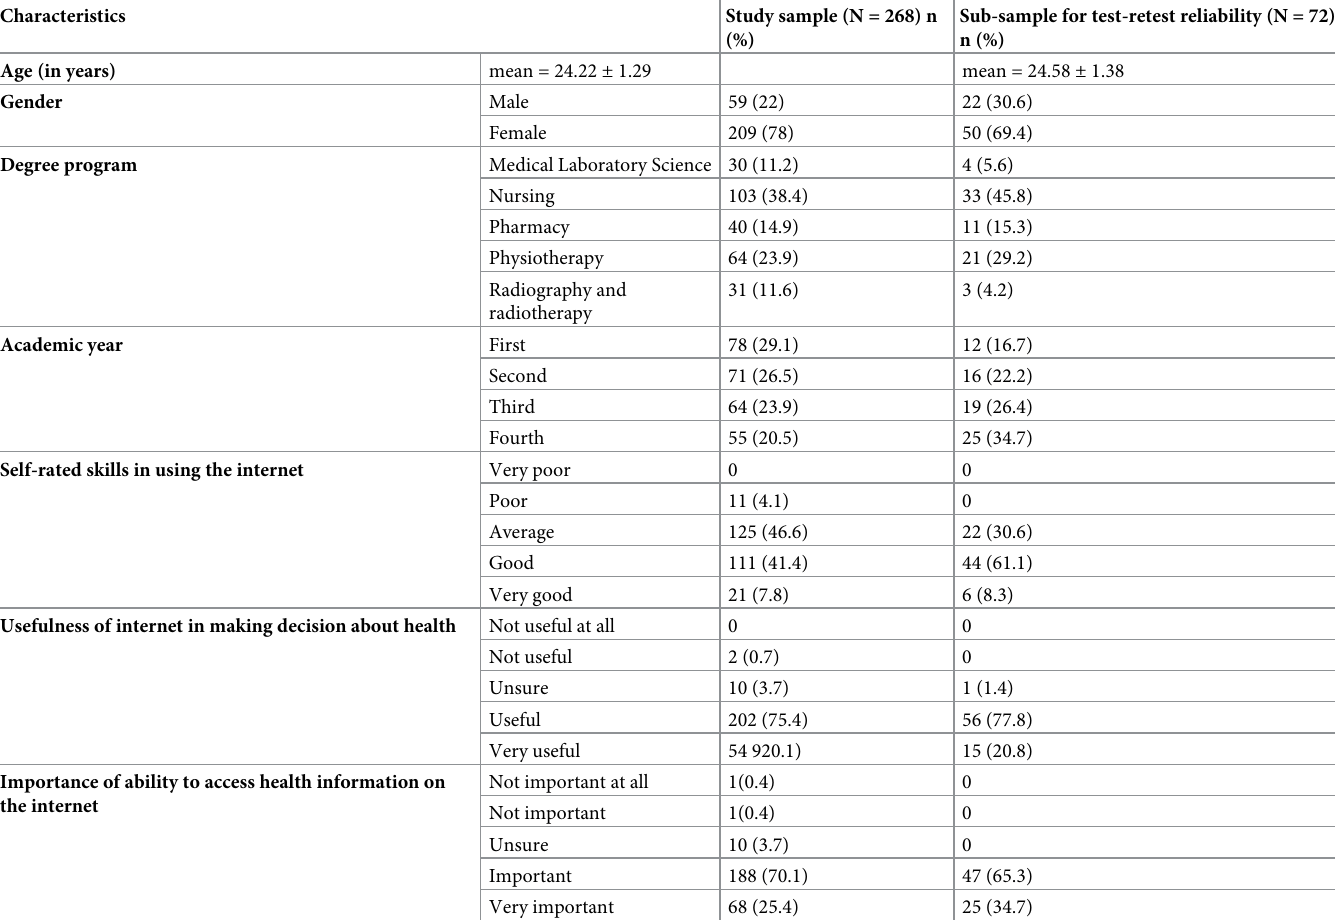
Table 1. Characteristics of the participants.